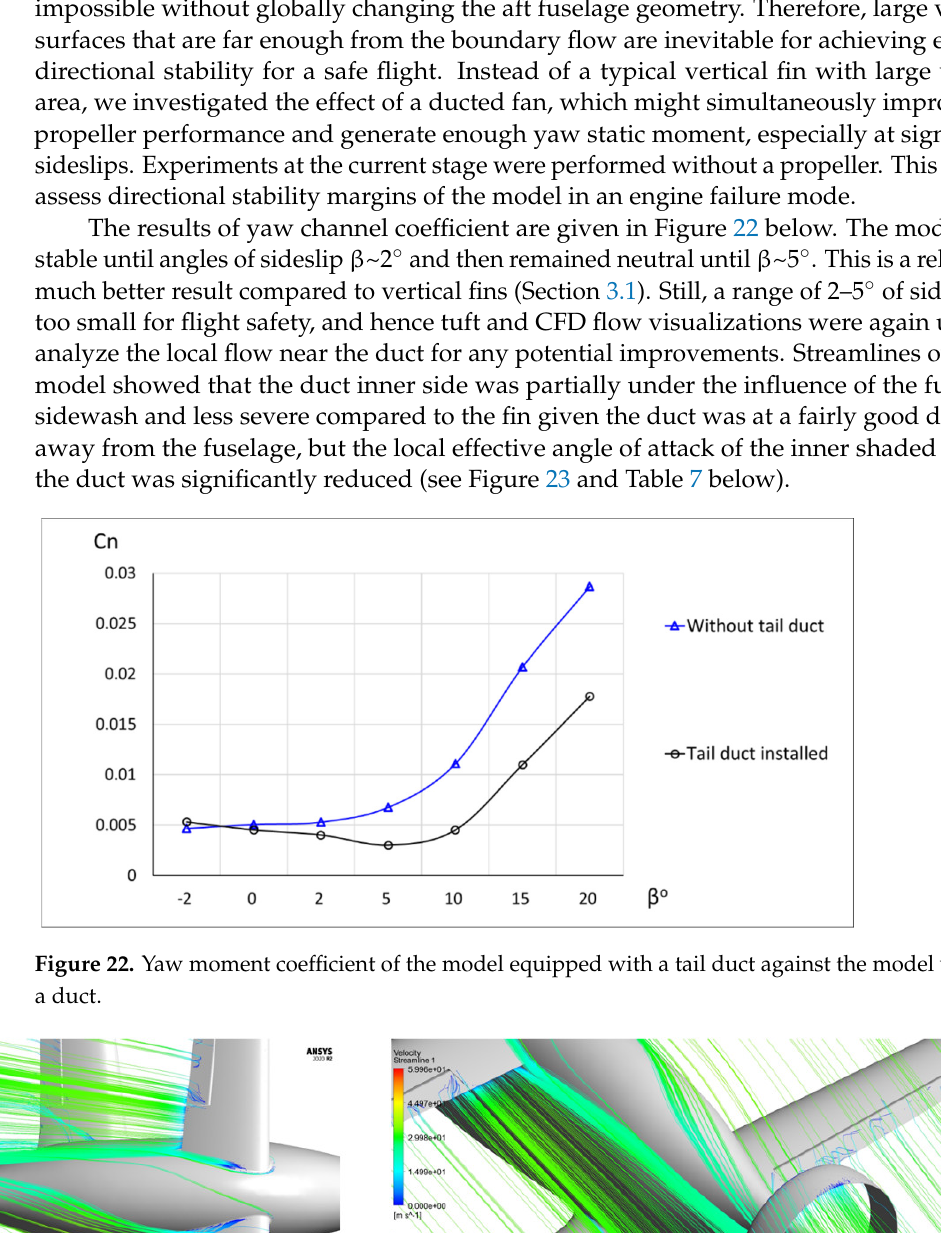
Figure 21. Lift/drag ratio of the model with and without wing root fairing.